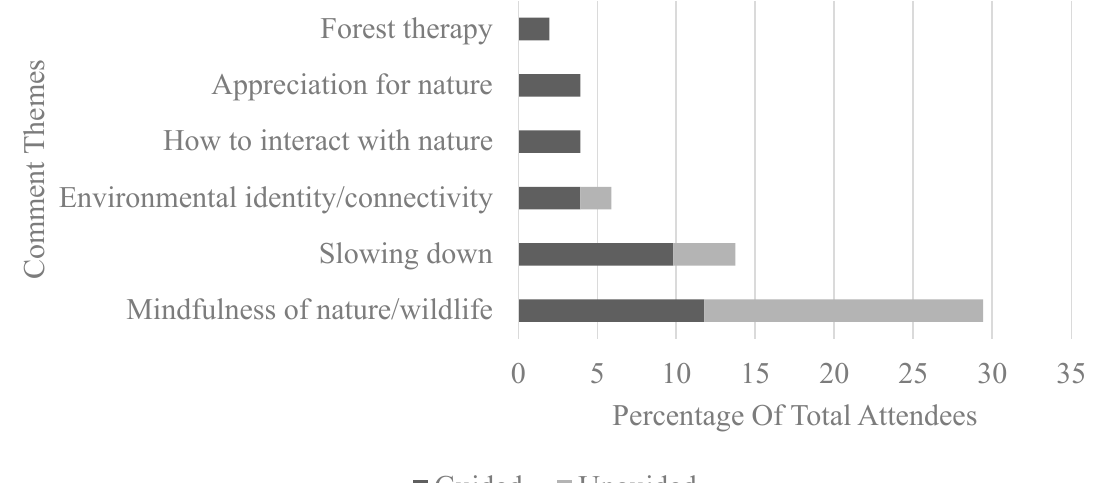
Figure 3. Descriptions of the nature immersion experience. Not all participants responded to open-ended items, so percentages do not represent the entire sample.